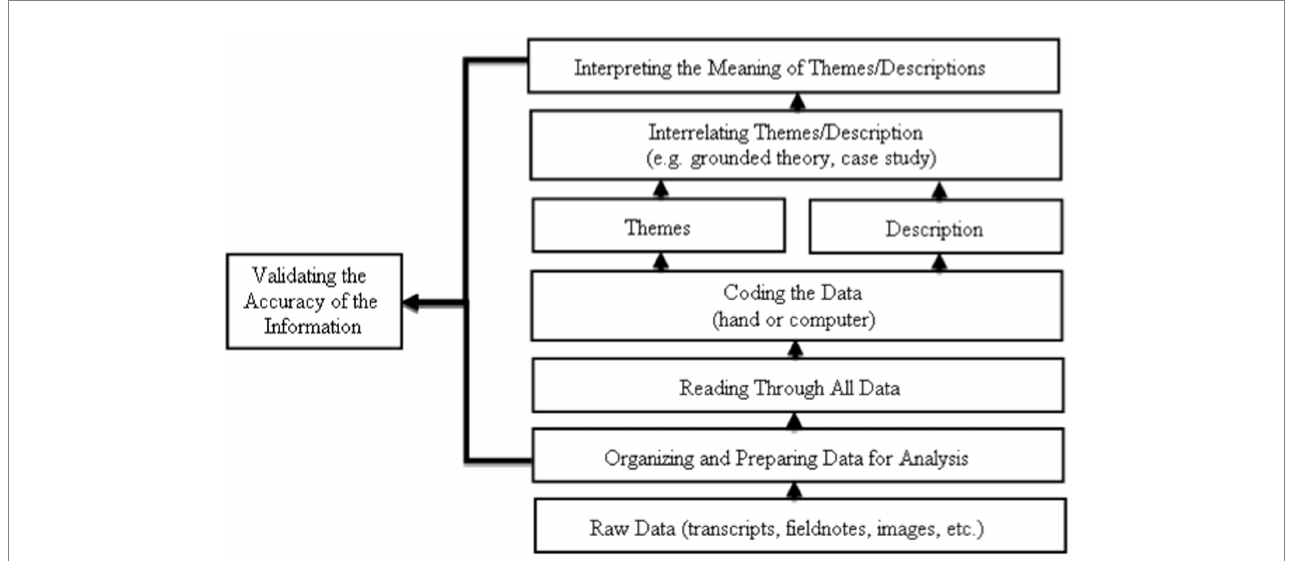
FIGURE 2 Data analysis steps (Creswell and Creswell,